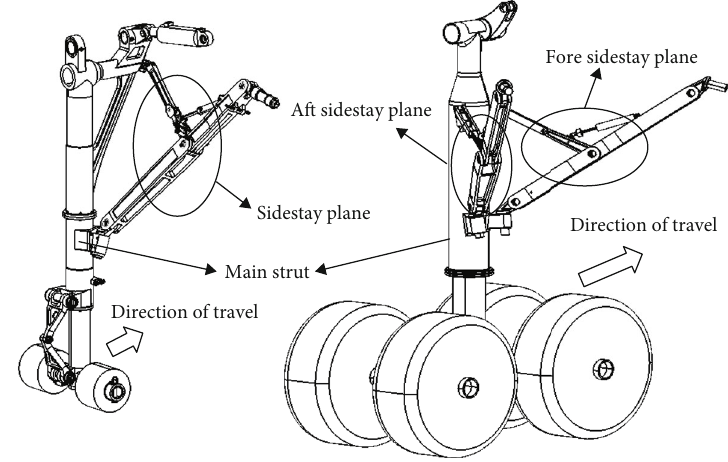
Figure 2: Changes in the DS versus SS landing